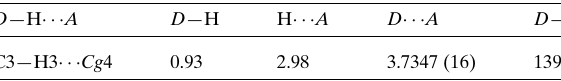
Table 1 Hydrogen-bond geometry (A˚ , (cid:2) ).